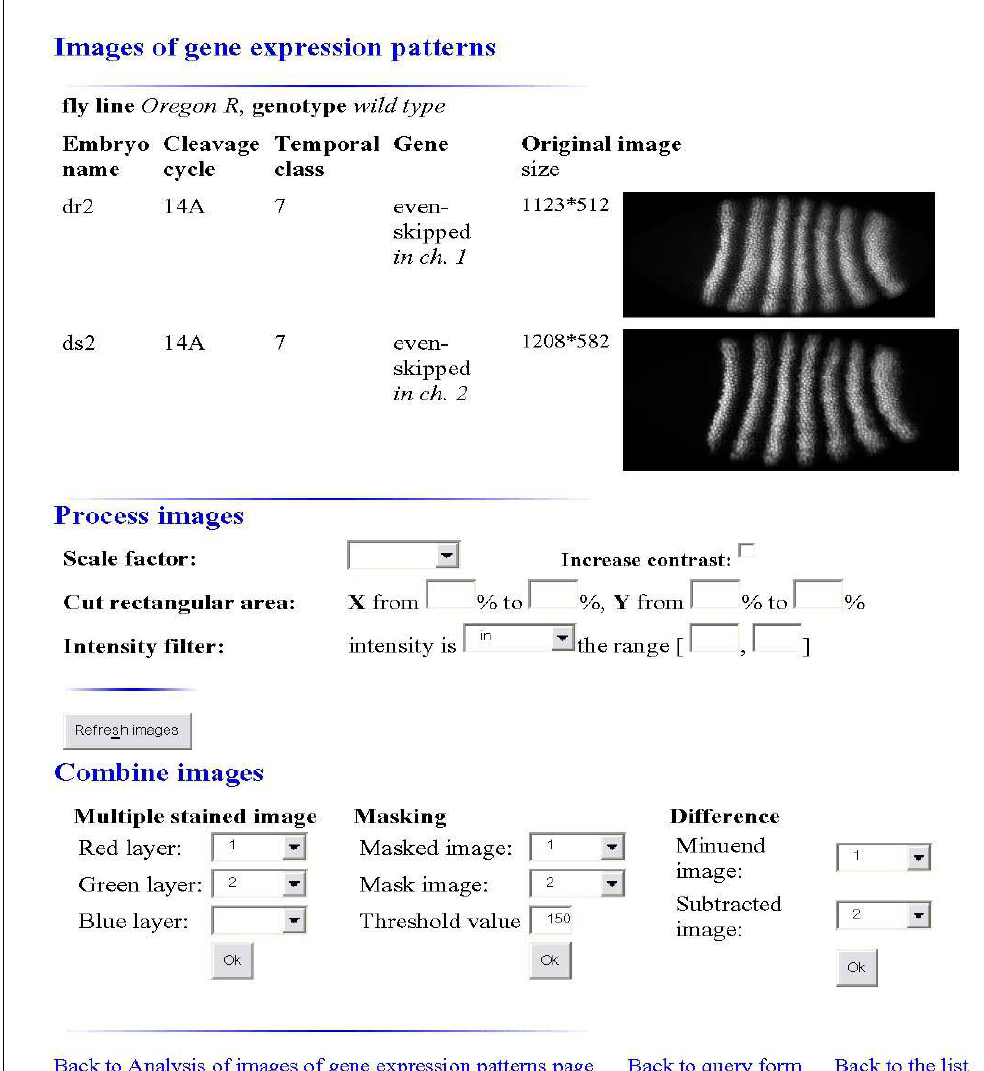
Figure 2: The result of sample query showing two images of expression of even-skipped gene scanned in the embryos dr2 and ds2 belonging to the cleavage cycle 14A, temporal class 7. The control panel for performing various manipulations with these images is presented below on the same